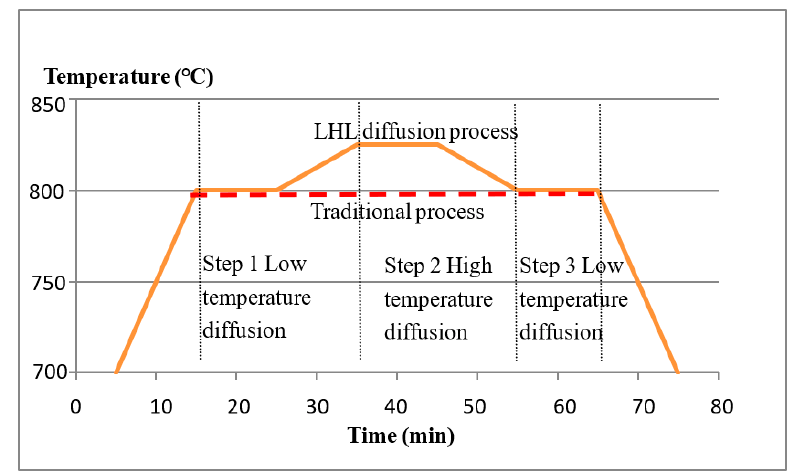
Figure 1. Schematic of BKM and LHL diffusion process. Table 1. Process parameters of BKM and LHL diffusion processes for p-type mc-Si solar